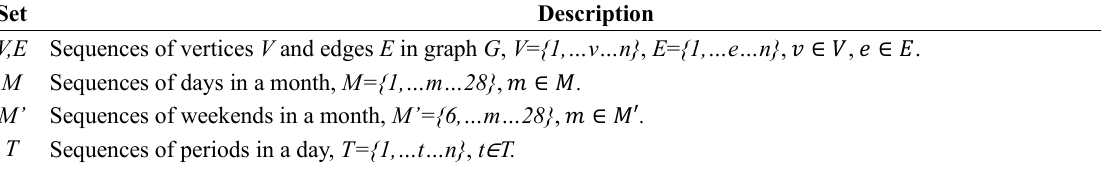
Definition of symbols. Set